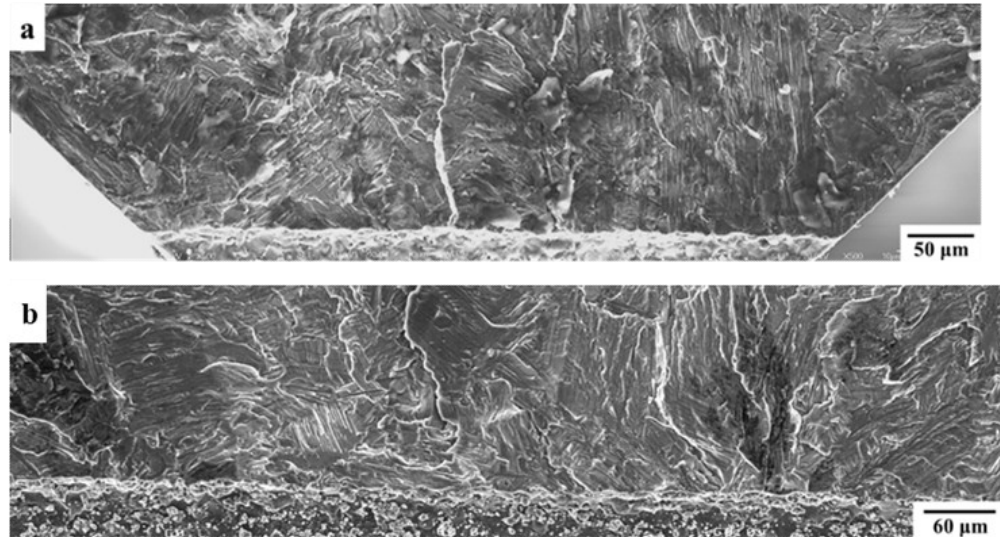
Figure 6. Fatigue crack initiation areas of ( a ) Specimen CC-8 and ( b ) Specimen CC-5, which were both tested at 650 °C with an R ratio of 0.1. The notch depths of CC-5 and CC-8 were 0.7 mm and 0.2 mm, respectively.